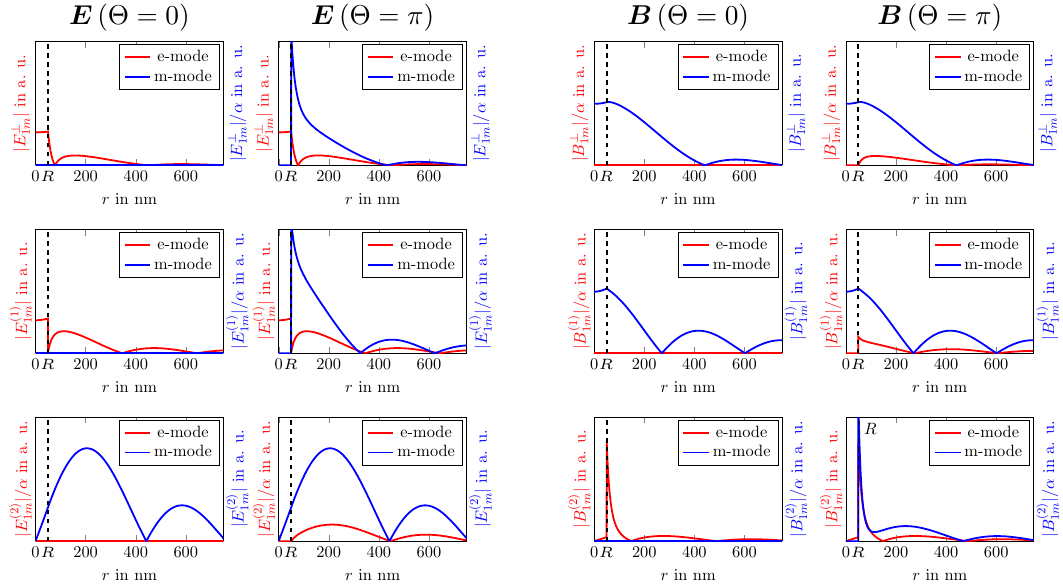
Figure 1: Radial dependency of electric (Eq. (25 - 27)) and magnetic (derived using Eq. (5)) field components (absolute value) of l = 1 normal modes for topologically trivial ( R = 50nm, ε = − 1, Θ = 0) and TI sphere ( R = 50nm, ε = − 1, Θ = π ) embedded in vacuum respectively at ħ h ω = 2eV. Note that the y-axis was always scaled in the same arbitrary